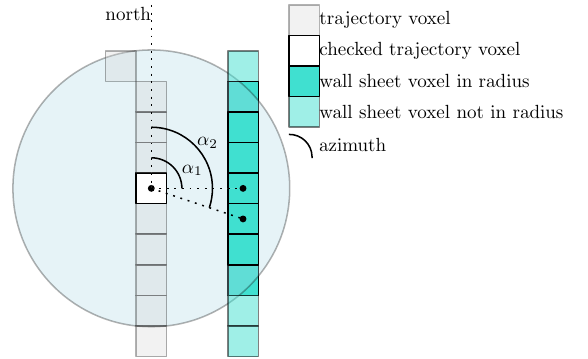
Figure 9. Top view of situation when trajectory goes along a wall